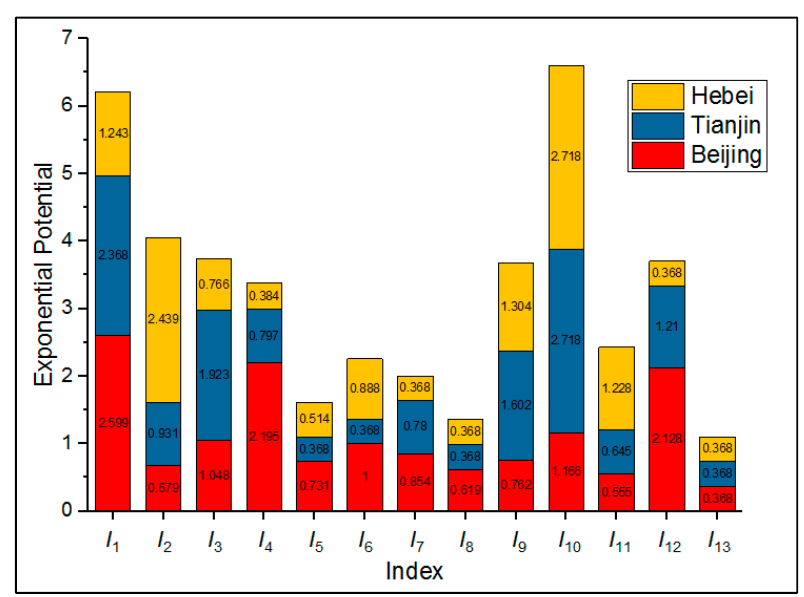
Figure 3. The state figure of set pair exponential potential in Beijing-Tianjin-Hebei Region. Table 11 . The state table of set pair exponential potential in Beijing-Tianjin-Hebei.